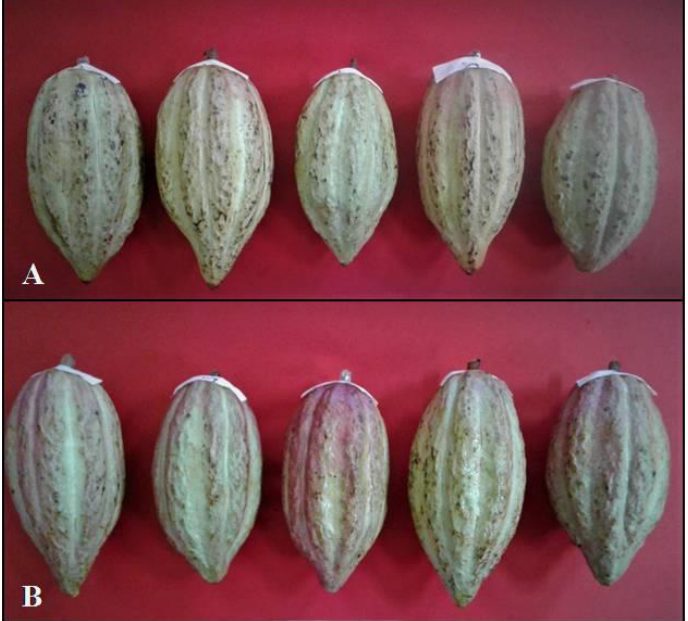
Figure 1. C. siamense inoculated ( A ) and uninoculated cacao pods ( B ) showing asymptomatic infection, 14 days after inoculation (DAI). Table 1. Re-isolation of C. siamense from inoculated cacao leaves by spraying method at different sampling times (days after inoculation, DAI).